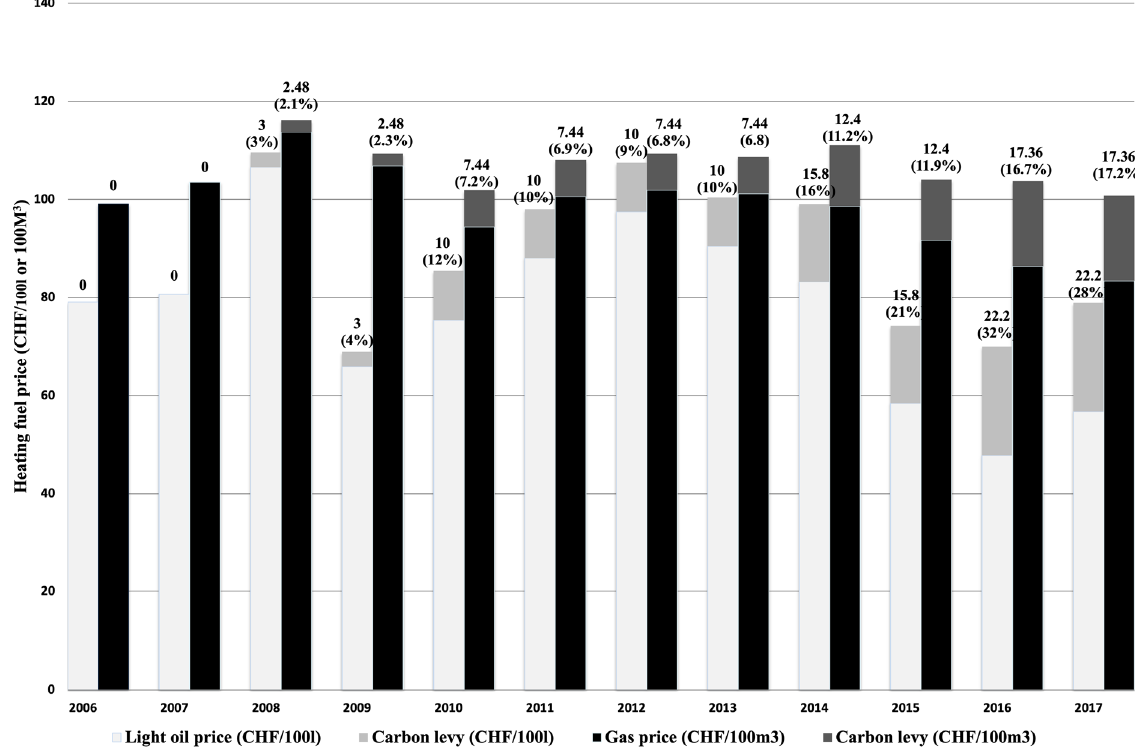
Figure A2. Light oil and natural gas price composition, 2006–2017. Sources: [53], own calculations.